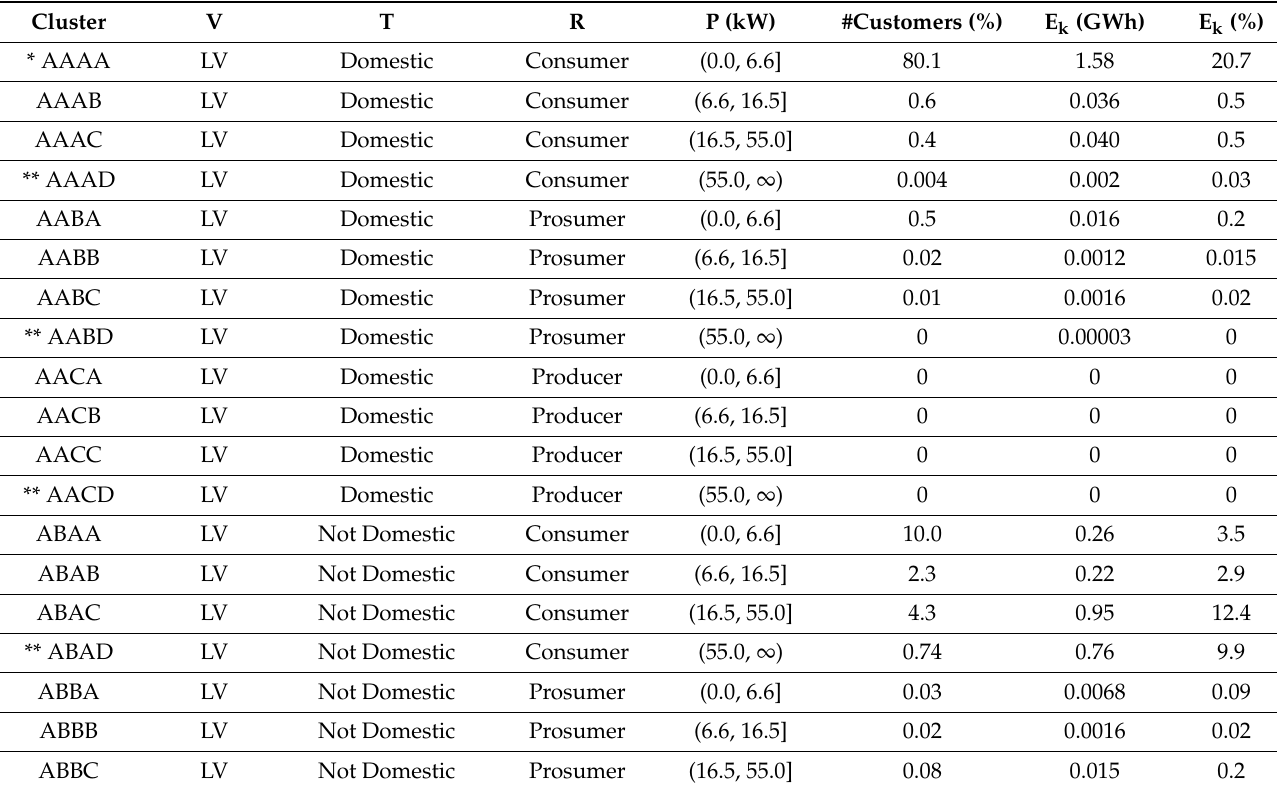
Figure 5. The percentage of total annual energy consumed by each cluster. Table 1. Output of the clustering, Level 1: number of customers, total energy and percentage of total energy consumed in a year per each